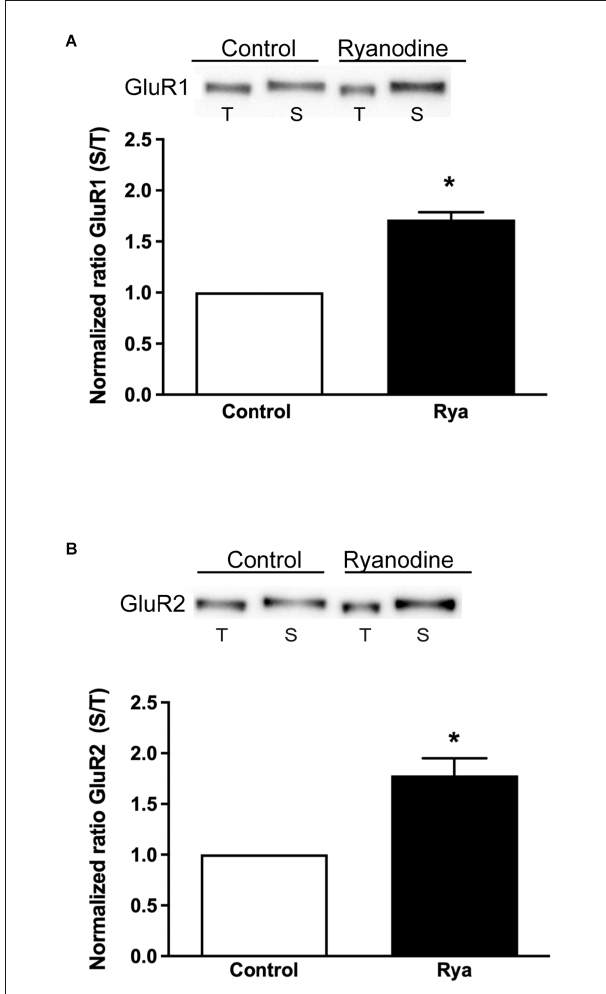
FIGURE6 Inhibitory ryanodine increased the surface expression of GluR1 and GluR2. The GluR1 and GluR2 surface membrane protein contents were normalized by the total amount of these subunits present in 20 µ g of protein extract. (A,B) Comparison between the normalized contents of GluR1 and GluR2 at the surface (S) vs. their total content (T). Protein contents were determined in control slices and in slices incubated for 1 h with 20 µ M ryanodine; the ratio between the surface and the total content displayed by control slices was given a value equal to 1. Values are expressed as Mean ± SEM. Statistical analysis was performed by Student’s t-test for a single sample. * p <